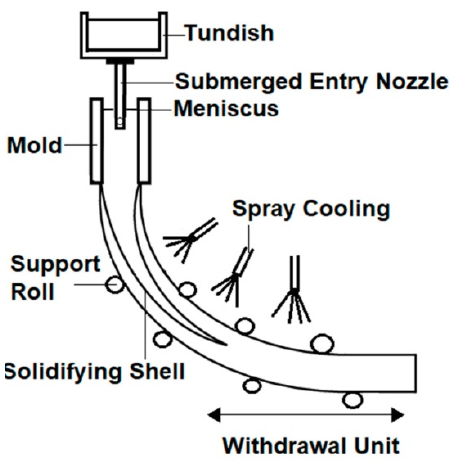
Figure 7 . Schematic of the continuous casting process. Figure 7. Schematic of the continuous casting